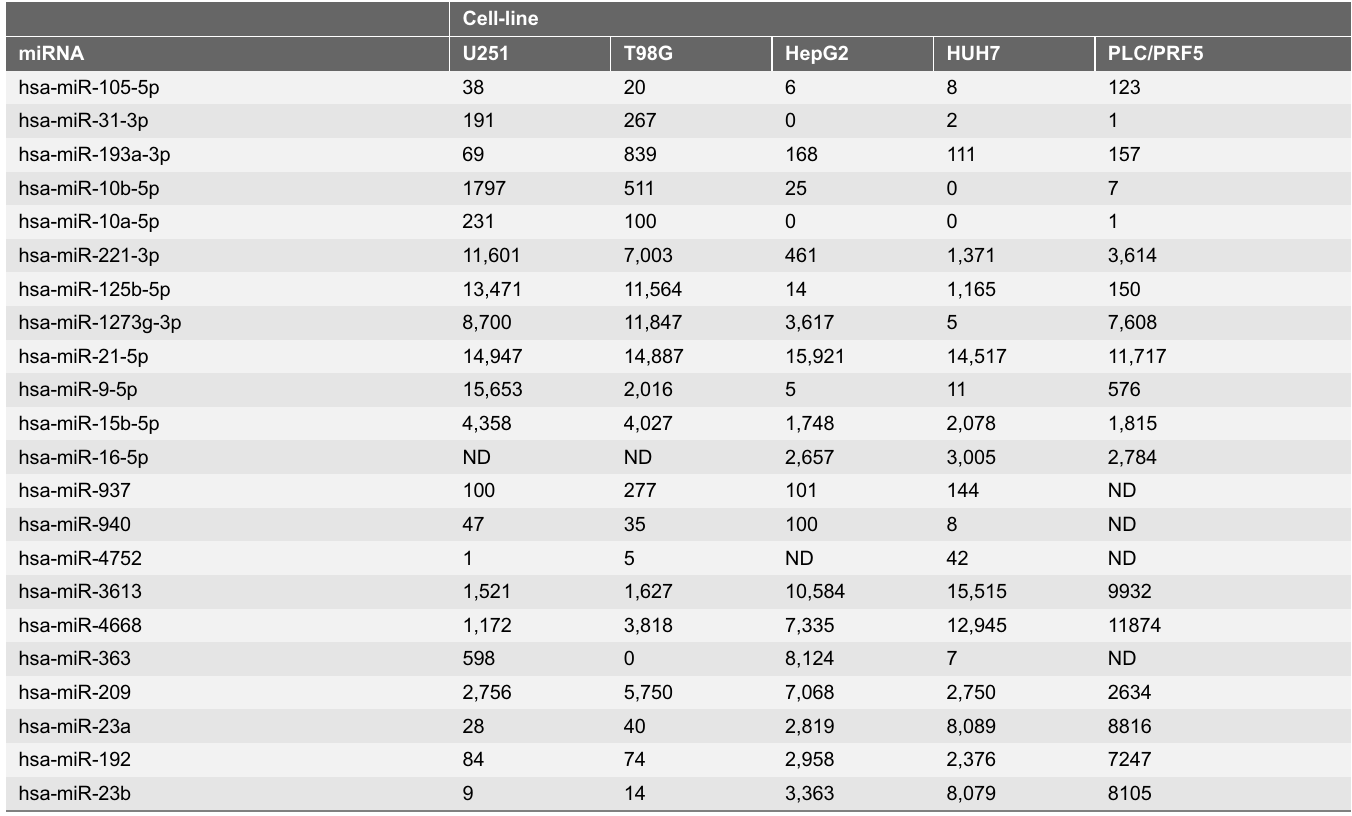
Table 3. MicroRNA expression profiling in various cancer cell-lines.